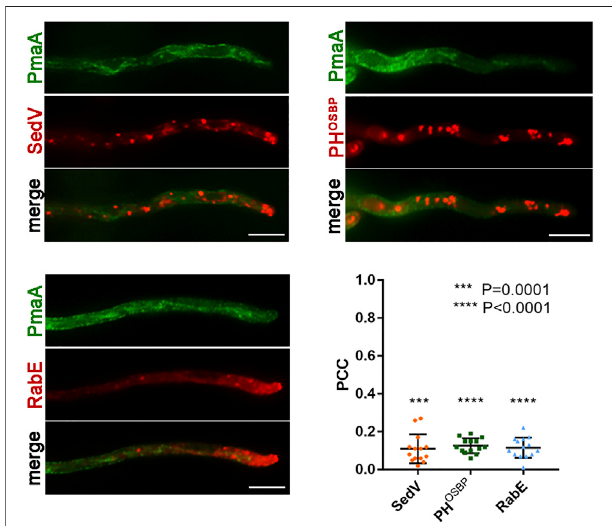
FIGURE 5 | Co-localization of PmaA with Golgi markers. Co-localization analysis and relevant quanti fi cation of strains co-expressing de novo -made PmaA-GFP with mCherry-SedV, mRFP-PH OSBP , and mRFP-RabE. Quanti fi cation by calculating Pearson ’ s correlation coef fi cient (PCC) shows a clear non-co-localization of PmaA with all the Golgi markers tested, as con fi rmed by the one-sample t -test (PCC = 0.11 ± 0.08 with *** p = 0.0001 for SedV, PCC = 0.13 ± 0.04 with **** p < 0.0001 for PH OSBP , and PCC = 0.12±0.05with**** p < 0.0001forRabE).Biological/technicalreplicates:3/14 for each